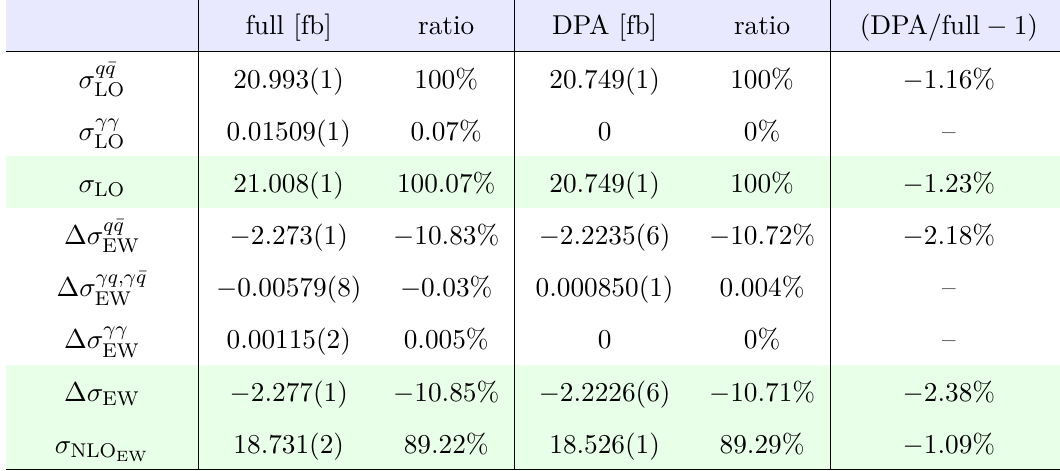
Table 1 . Contributions to the NLO EW cross-section for four-lepton production at the LHC in the full and DPA (unpolarized) computation. Ratios are computed relatively to the LO result for the q ¯ q partonic channel. The INC setup is understood (see section 2.5). Numerical errors are shown in